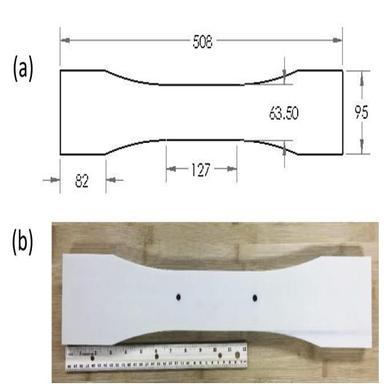
(a) Large tensile specimen dimensions (mm), a thickness of 19 mm, (b) Image of the harvested tensile specimen.